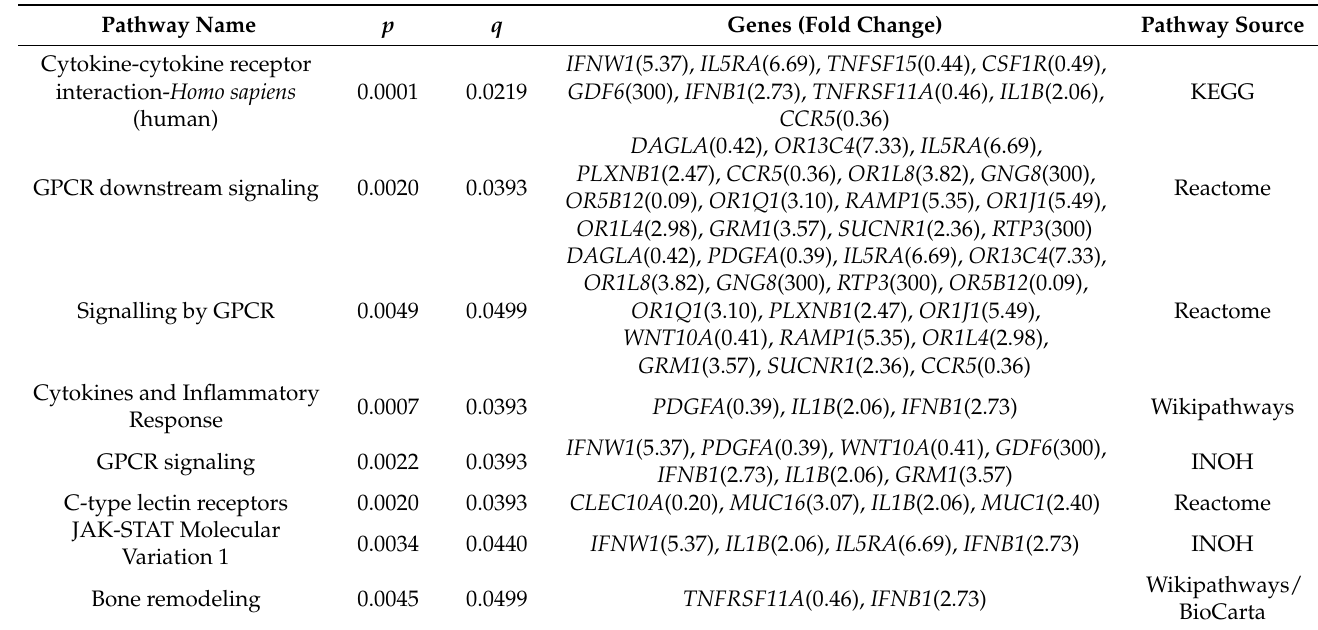
Table 2. Selected pathways of interest with known functions in the pathway analysis of the RNA ex- pression data with platelet-decreased NK-AML (PD-AML; <100 × 10 9 /L) from platelet-not-decreased (PND-AML; ≥ 100 × 10 9 /L).